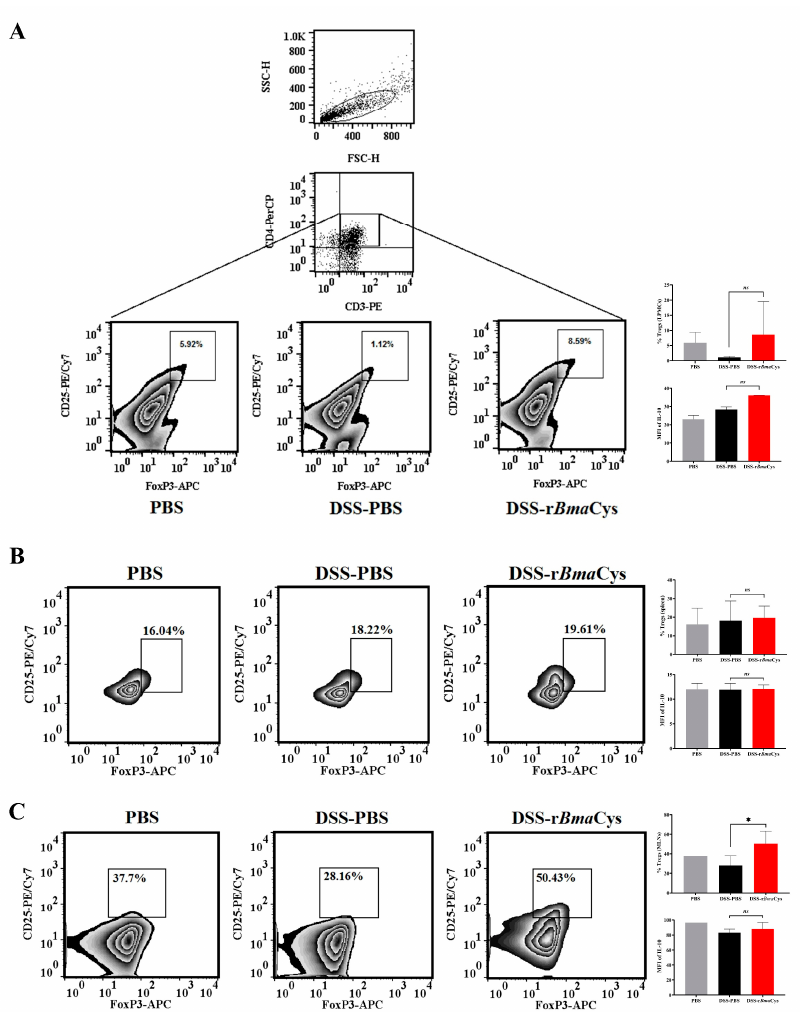
Figure 3. Frequency of Tregs was increased following r Bma Cys-treatment. ( A ) Colon tissues were homogenized and digested with collagenase, DNase, and dispase to produce a cell suspension which was then purified with percoll gradient to isolate lamina propria mononuclear cells (LPMCs). The isolated LPMCs were then subjected to flow cytometric analysis after surface staining with fluorescently labeled anti-CD3, anti-CD4, anti-CD25, and intracellular staining with anti-FoxP3 and anti-IL-10 antibodies. There was a marked increase in the percentage of Tregs in the colon LPMCs of DSS-r Bma Cys-treated group compared to DSS-PBS and PBS control group of mice. Intracellular staining showed that the majority of these Tregs were positive for IL-10 (mean fluorescence intensity, MFI, Σ ) in the DSS-r Bma Cys-treated group compared to the DSS-PBS and PBS control mice. ( B ) Spleen cells were stimulated with the anti-CD3 and anti-CD28 antibodies for 72 h and then fluorescently labeled. Flow cytometric analysis showed that there was no significant di ff erence in the percentage of Tregs or the MFI of IL-10. ( C ) However, analyses of the mesenteric lymph nodes (MLNs) from mice in each group showed that there is an increase in Tregs in the lymph nodes of DSS-r Bma Cys-treated mice compared to DSS-PBS mice; no di ff erence in the MFI of IL-10 was observed between DSS-r Bma Cys-treated mice and DSS-PBS mice. Each bar represents mean ± S.D values. n = 10 mice per group, except DSS-PBS group which had 8 mice except n = 2 for Figure 3A (colons from 5 male mice and 5 female mice within each group were pooled to collect su ffi cient LPMCs for this assay). * P ≤ 0.05 compared to DSS-PBS group as determined using one-way ANOVA followed by Tukey’s posthoc test. ns = not